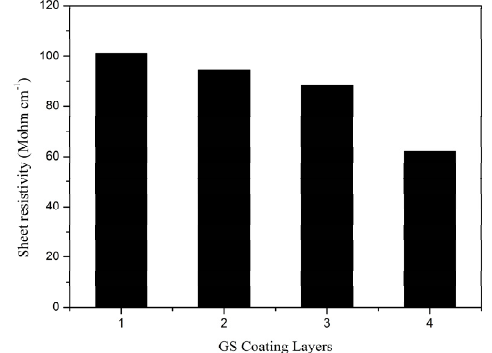
Figure 3. Effect of GS coating on electrode resistance